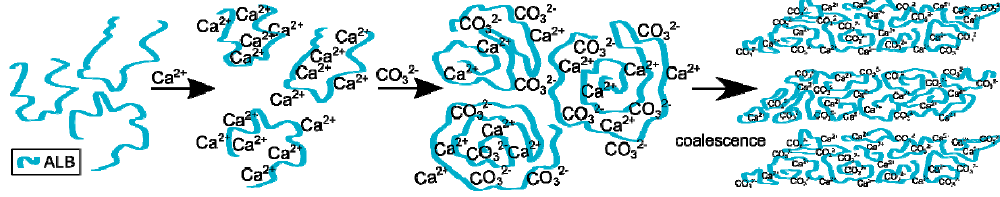
Figure 11. Scheme of the process of calcium carbonate formation in the presence of ovalbumin.